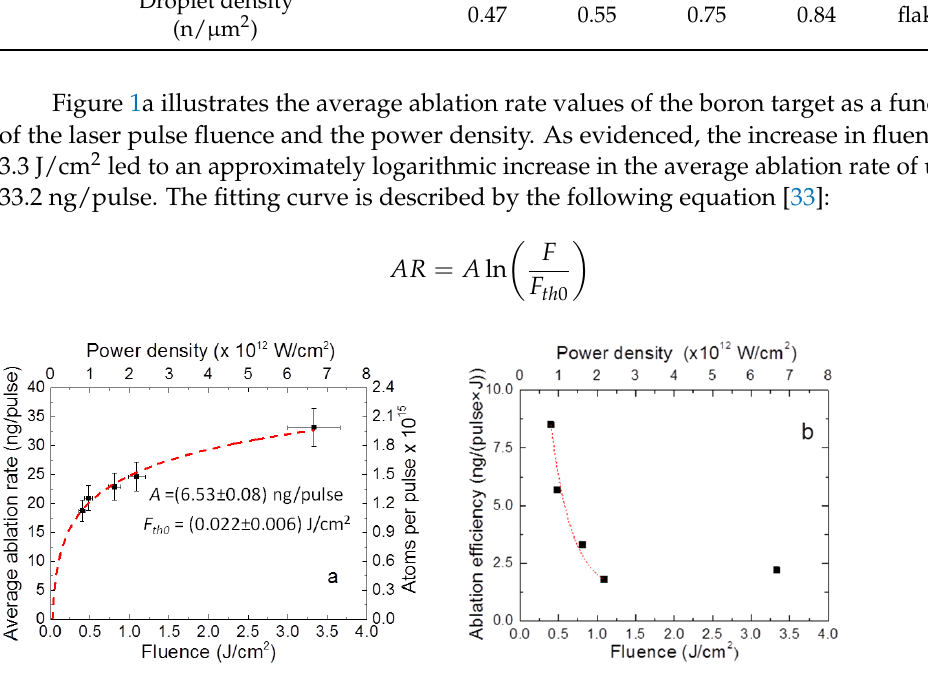
Figure 1. Fluence dependence of the ( a ) average ablation rate and number of boron atoms ablated per single pulse (black scatter points) with a fitting logarithmic curve (dashed red line) and ( b ) ablation efficiency (black scatter points) with a fitting exponential curve (dashed red line).